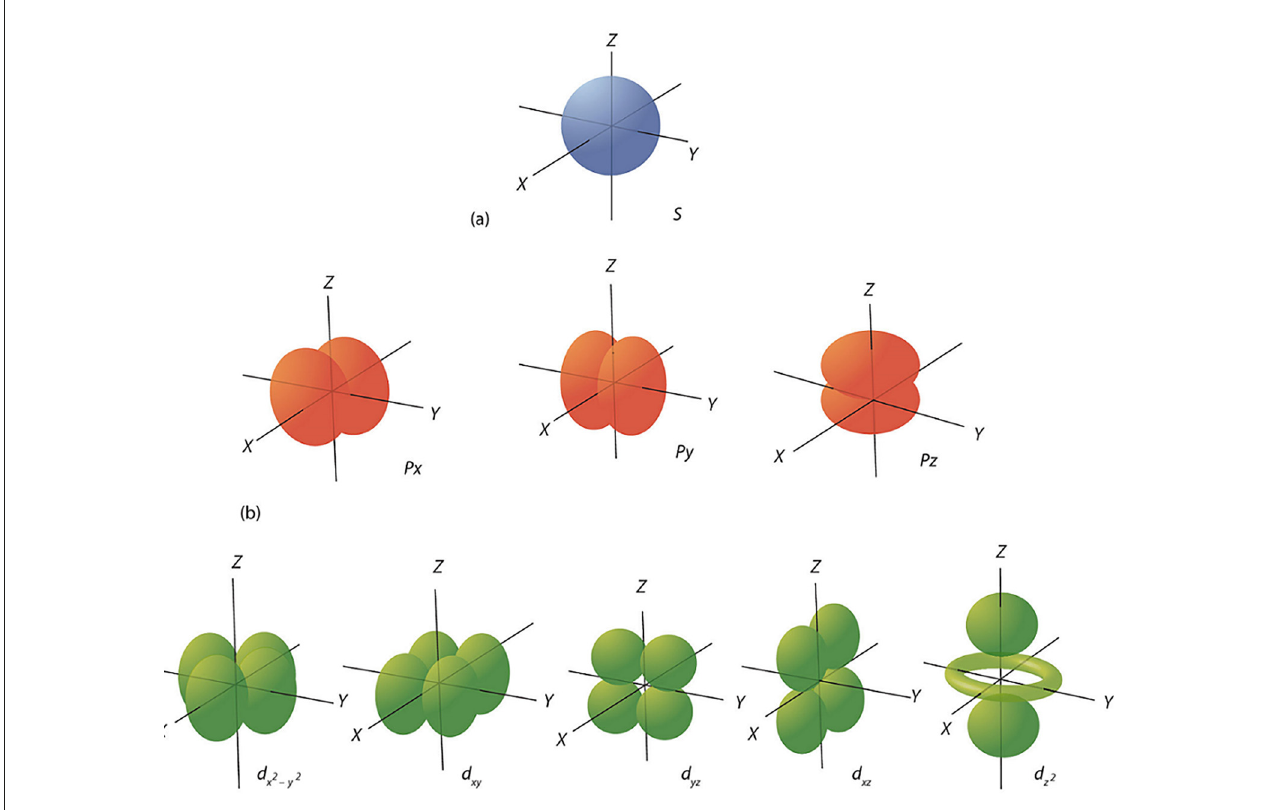
FIGURE1 Diagram of atomic s, p, d orbitals (Blendspace,